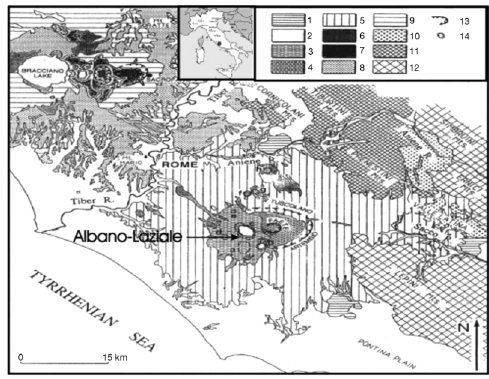
Fig. 1. Location of the survey